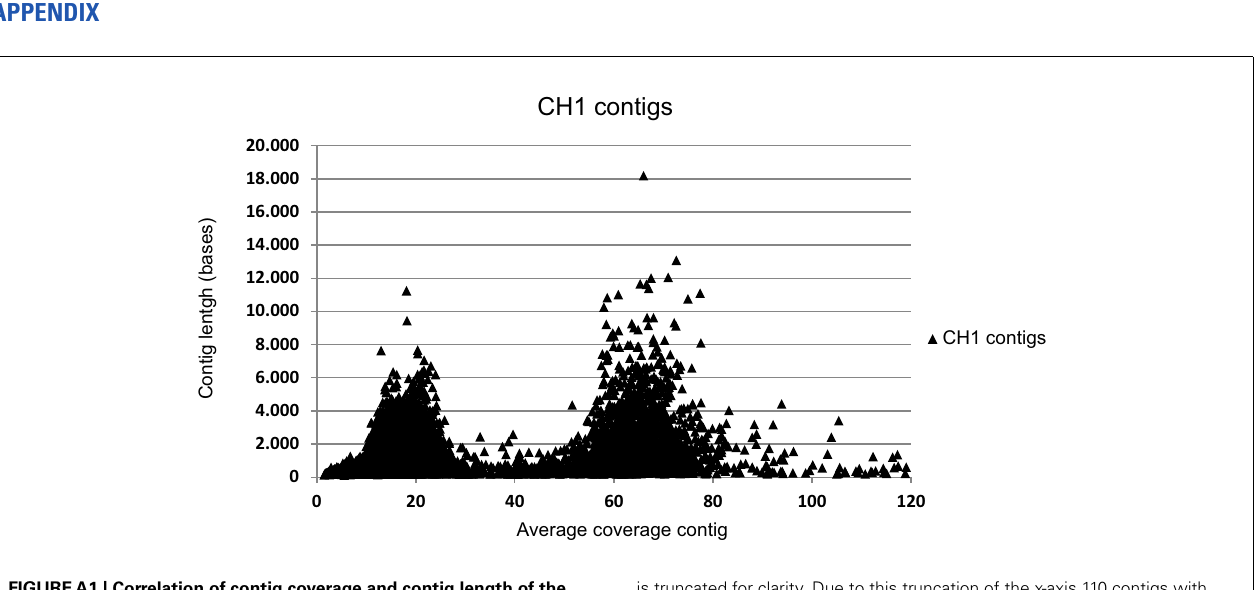
is truncated for clarity. Due to this truncation of the x-axis 110 contigs with coverage over 120-fold are not shown, but were used in further analysis as part of the “high coverage”